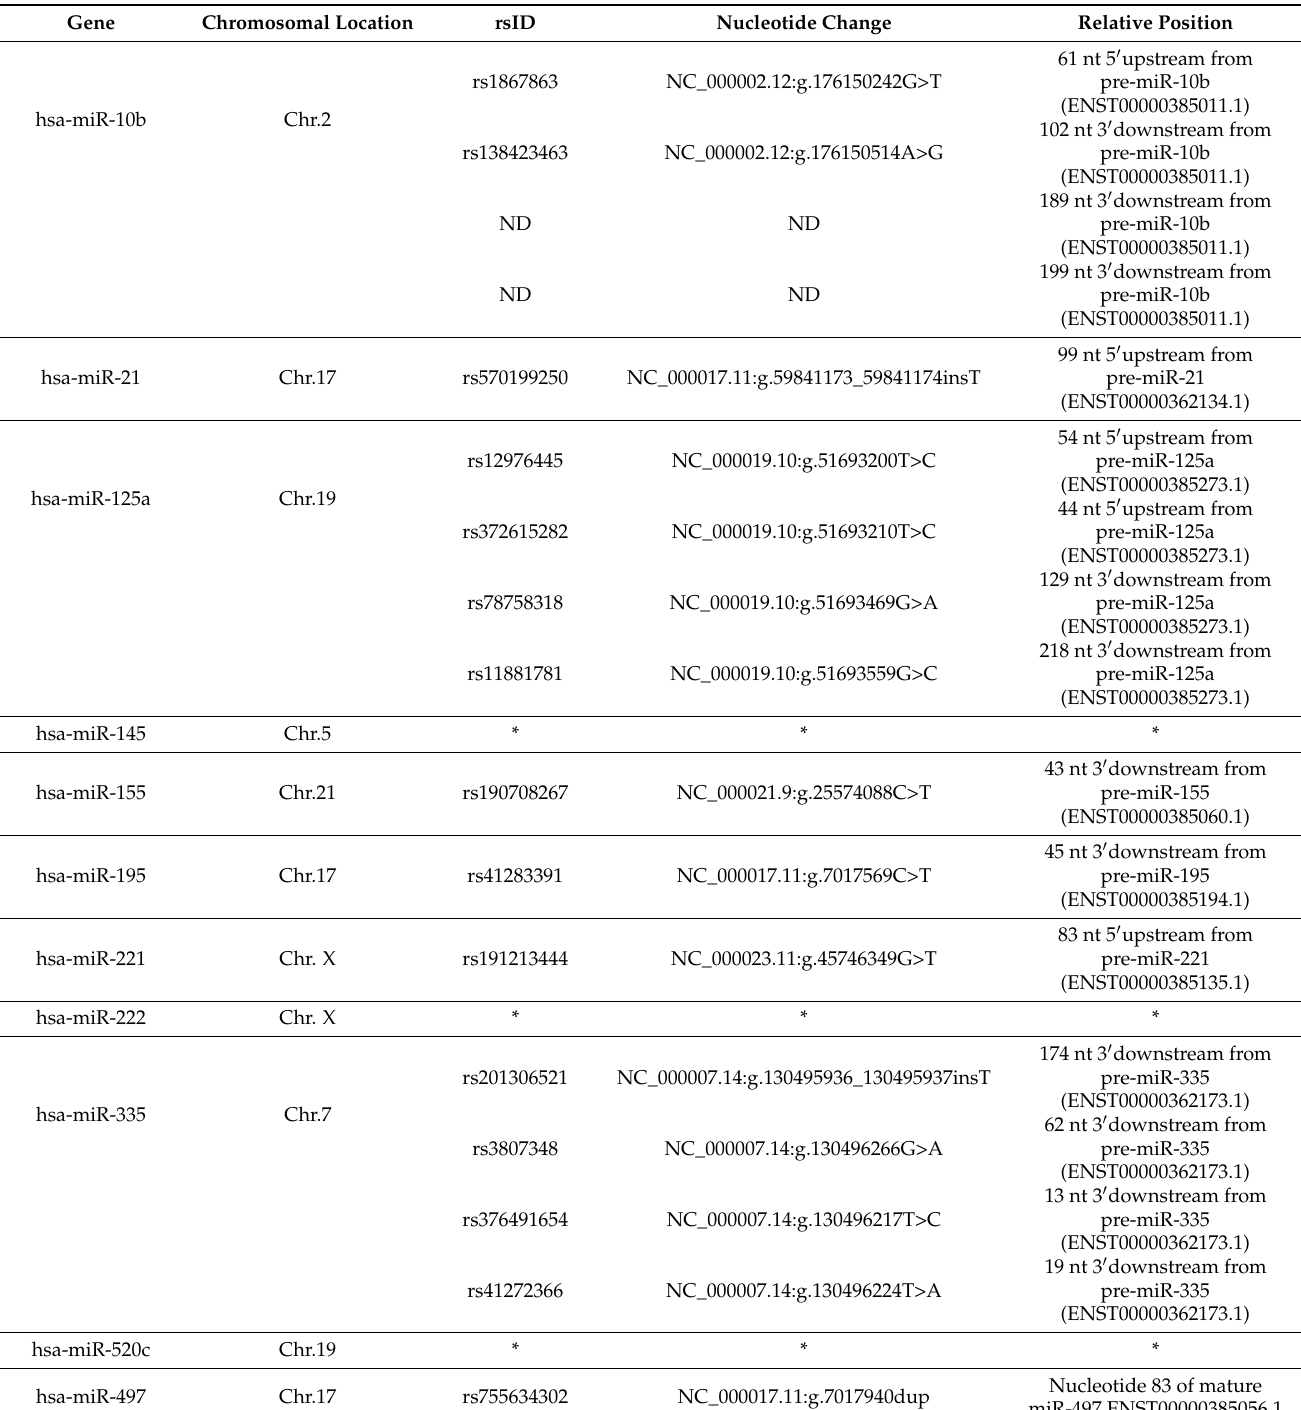
Table 1. Germline variants found in sequenced miRNA